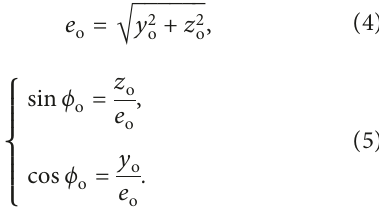
Figure 2: Contact model between the outer ring and